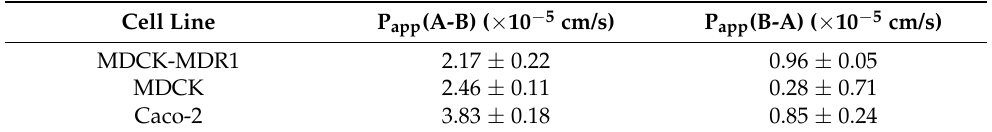
Table 3. Apparent permeability coefficients (Papp) for JM-20 using MDCK, MDCK-MDR1 and Caco-2 cell lines (37 ◦ C, stirring at 50 rpm).